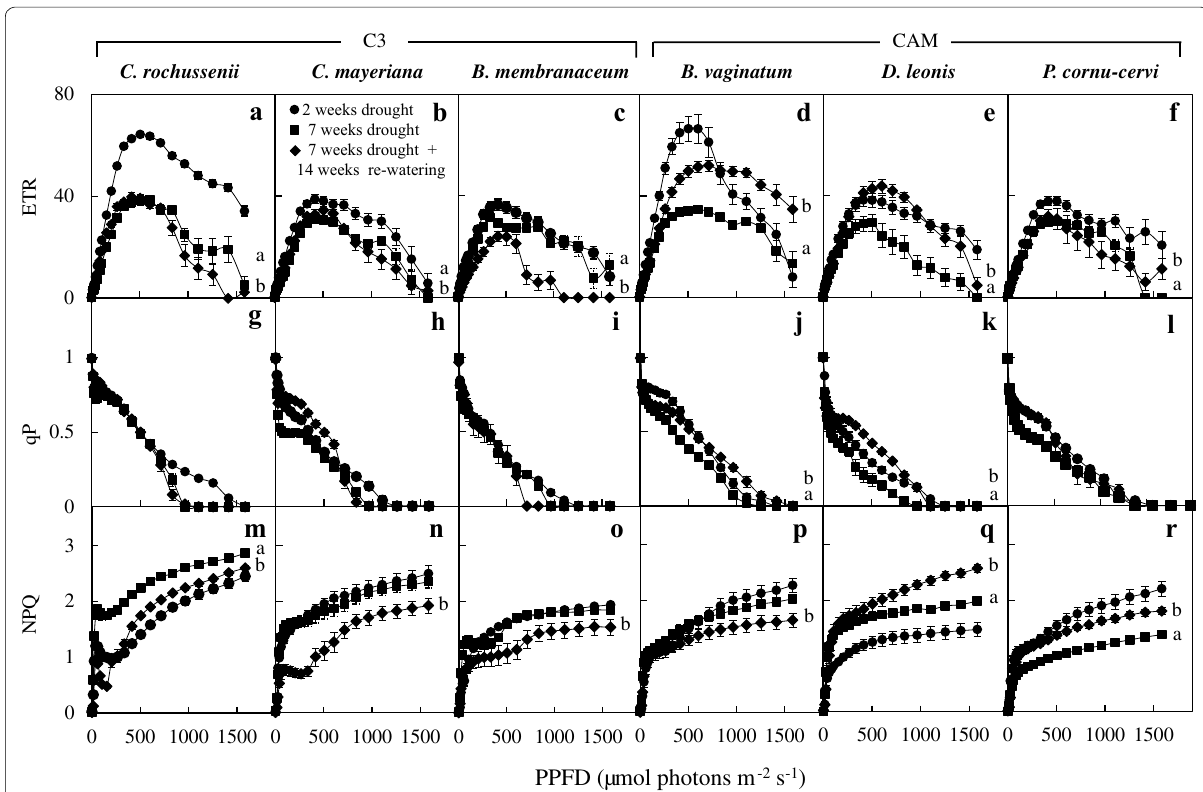
Fig. 4 Changes in ETR ( a – f ), qP ( g – l ) and NPQ ( m – r ) of the six species after 2 and 7 weeks of drought and after 14 weeks of re-watering under moderate light. Vertical bars represent standard error. The letters at the end of the curves indicate statistical difference in ETR, qP and NPQ either between weeks 2 and 7 (letter a), or between 7 weeks of drought and after 7 weeks of drought with 14 weeks of re-watering (letter b), One-way ANOVA, p < 0.05, n 3. No letters at the end of the curve indicate no significant =